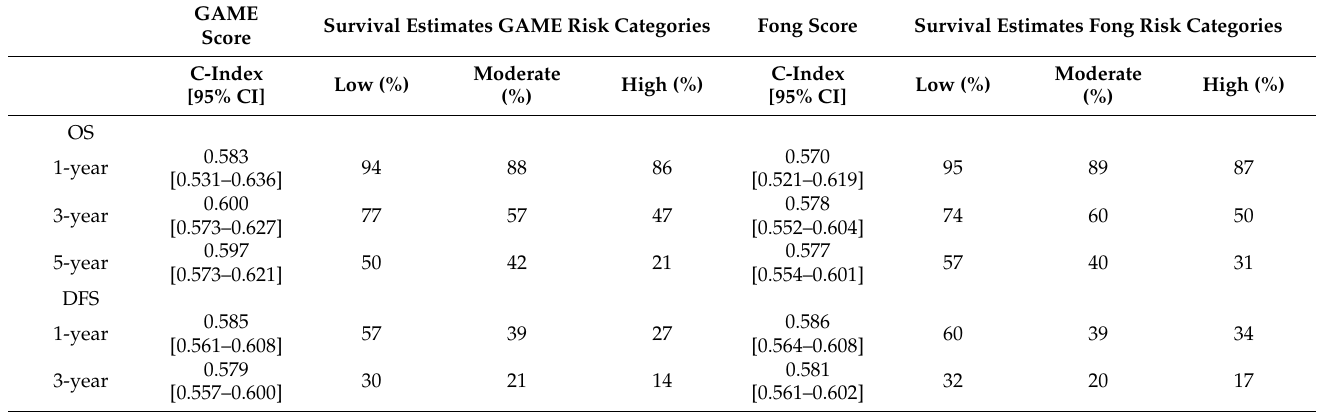
Table 3. Pooled Harrell’s concordance index with 95% confidence intervals for 1-, 3-, and 5-year overall survival and disease-free survival outcomes for GAME and Fong risk scores and survival estimates at 1-, 3-, and 5 years for low-, moderate-, and high-risk groups according to GAME and Fong prediction